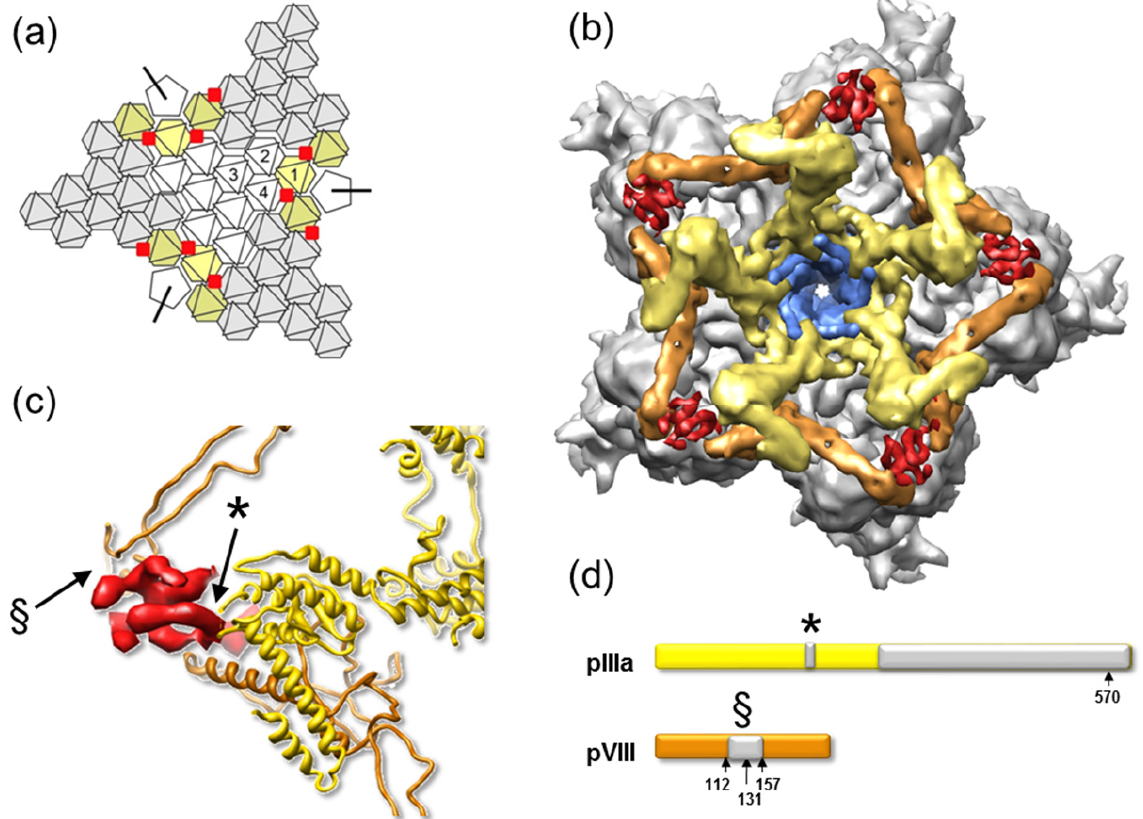
Figure 8. The molecular stitch in immature AdV. ( a ) Schematics showing four adjacent icosahedral facets, with the position for the molecular stitch inside the capsid in red. ( b ) The GOS represented as in Figure 5, with the density for the molecular stitch derived from the ts1 -WT difference map at 8.9 Å in red. The five peripentonal hexons are shown in gray; penton base in blue; polypeptide IIIa in yellow; and the GOS copy of polypeptide VIII in tan. View from inside the capsid looking at the 5-fold icosahedral symmetry axis. ( c ) Zoom into the region close to one of the molecular stitches with the structures of IIIa and VIII from [4] represented in ribbons. ( d ) Bars representing the precursor polypeptides IIIa and VIII with the cleavage sites indicated (arrows). Polypeptide regions not traced in the cryoEM atomic structure are in gray. Untraced regions close to the molecular stitch are indicated with the same symbol in (c) and